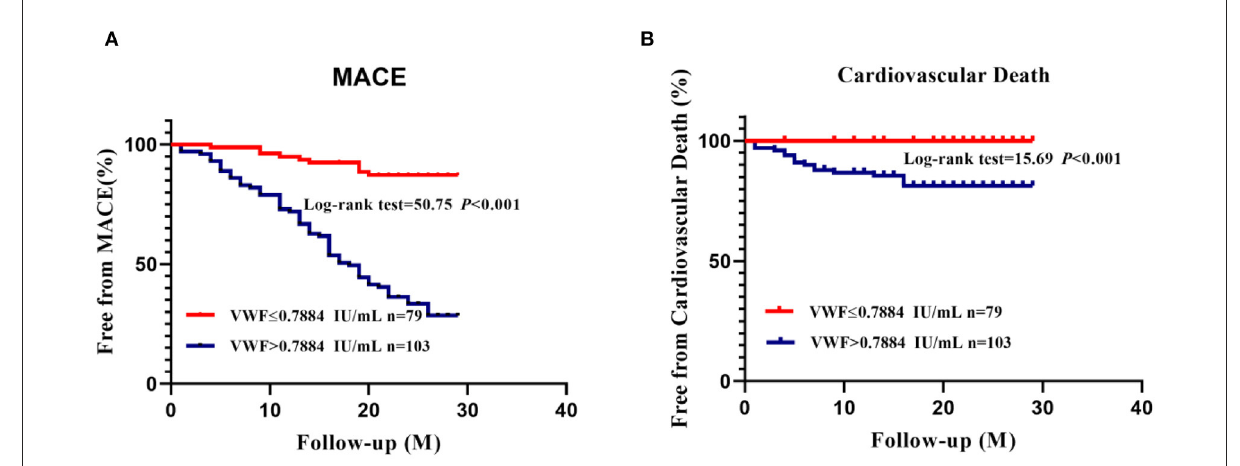
FIGURE4 K–M curves for MACEs (A) and cardiovascular death (B) according to the best cut-off value of VWF: Ag.